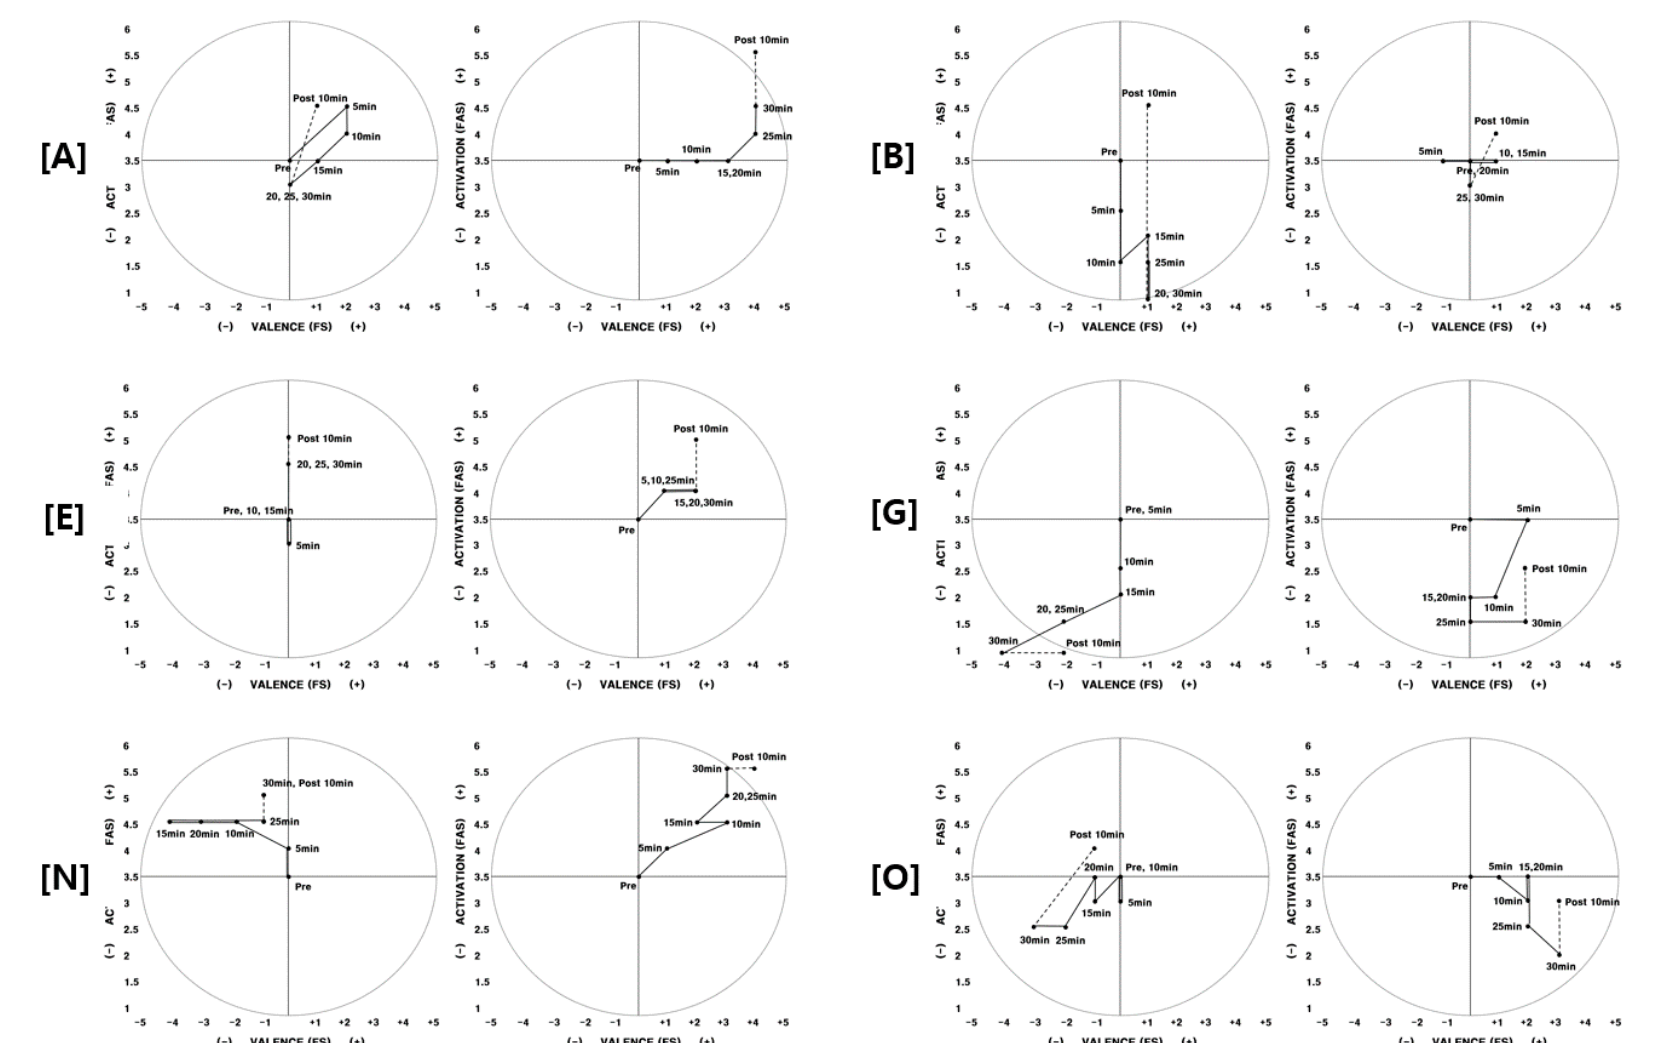
Figure 2. 2D circumplex model (participants A, B, E, G, N, O) Note. Left: 1st experiment / Right: 2nd experiment. FAS: felt arousal scale; FS: feeling